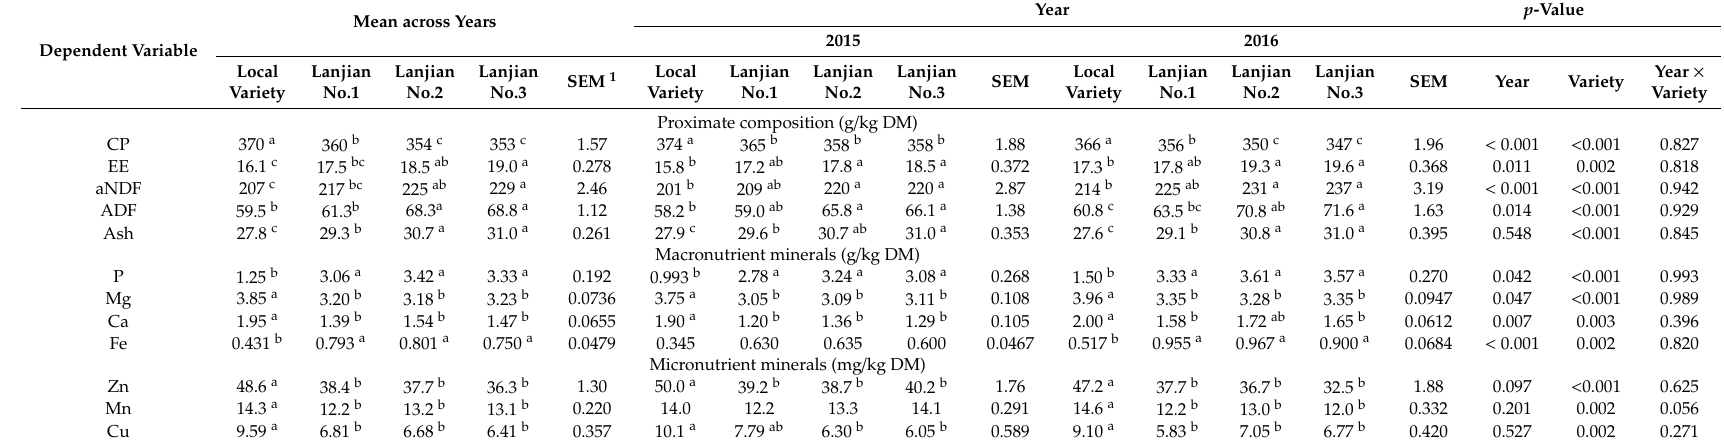
Table 3. E ff ects of cropping year, variety, and the year × variety interaction on the chemical composition of four common vetch grain varieties grown on the Tibetan Plateau.